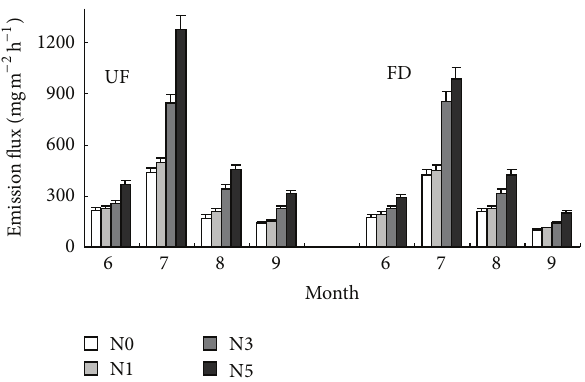
Figure 6: Effects of N-deposition on the wetland CO 2